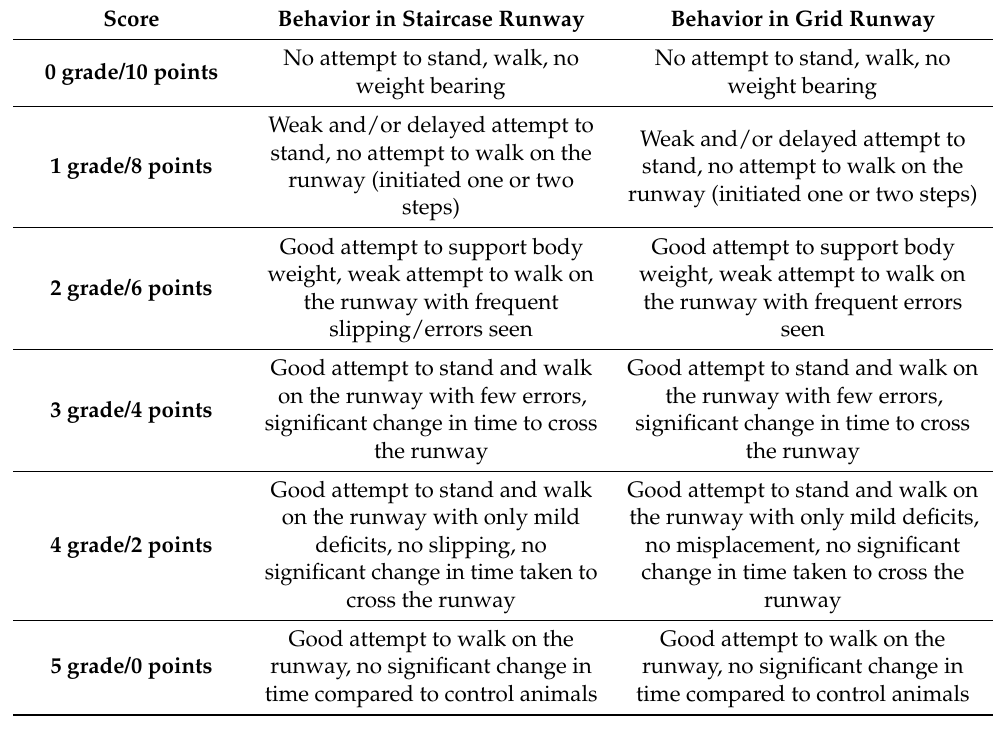
Table 1. Score for Grid runway and Staircase runway.